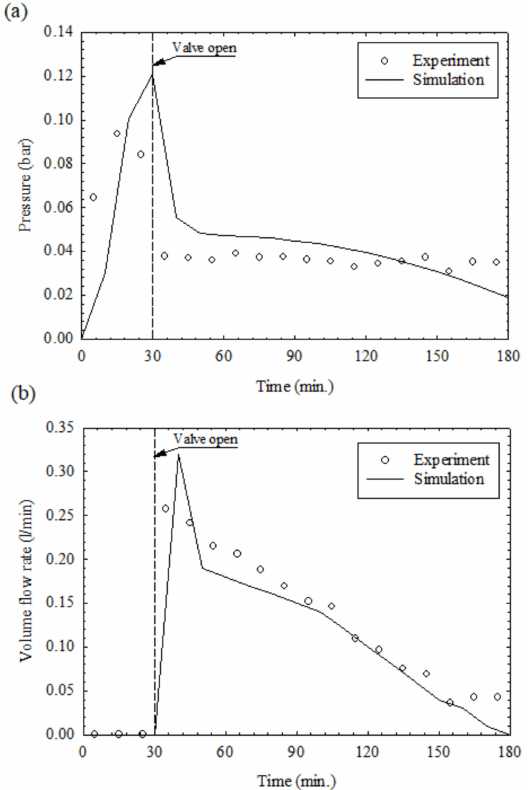
Figure 6. Pyrolysis reactor ( a ) pressure and ( b ) exhaust gas flow rate